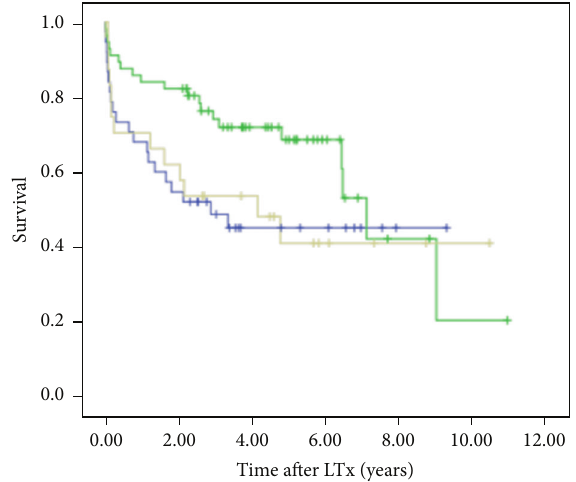
Figure1:SurvivalcurvesinLTxrecipientsaccordingtothepresence ofheterozygousHLA-E(ingreen)comparedtohomozygousHLA-E (homozygous HLA-E ∗ 01:01 in light grey, homozygous HLA-E ∗ 01:03 in blue) (log-rank test, 𝑝 = 0.01